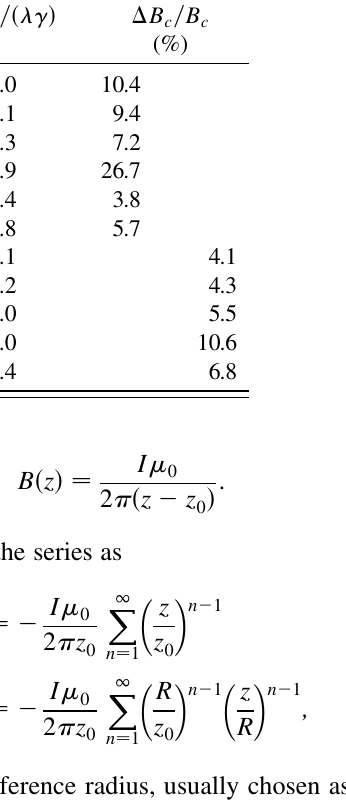
TABLE VIII. Increase of parameters (cid:6) and (cid:3) , and of the short sample field, due to the iron yoke for 7 Nb-Ti and 4 Nb Sn dipoles. 3